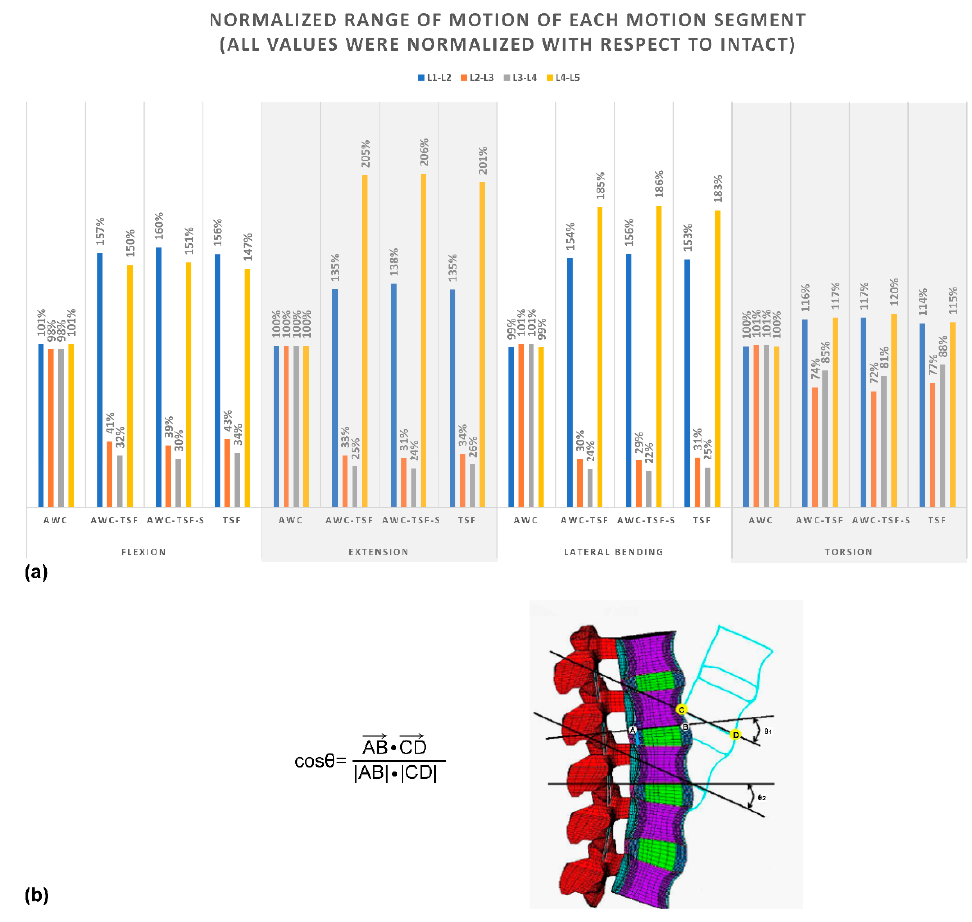
Figure 2. ( a ) Range of motion of each motion segment in all implanted models, all values were normalized with respect to intact. ( b ) Method to determining the ROM ( θ 1 represent the ROM angle of L2-L3, θ 2 represent the ROM angle of L3-L4); the cyan contour in solid line represent the lumbar segments after motion.